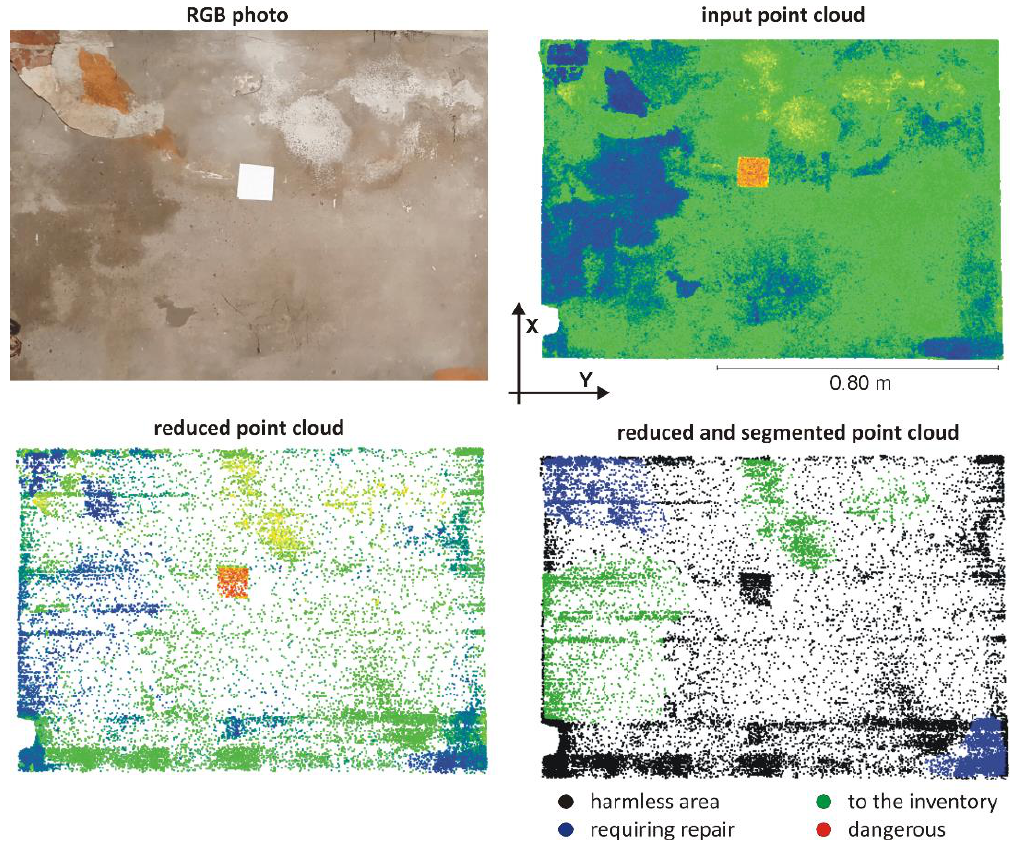
Figure 4. Detection of basement wall defects based on OptD segmentation in OXYI coordinate system – object1 fragment1